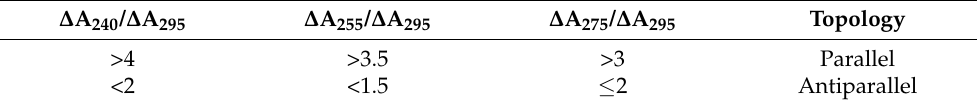
Table 2. Reference TDS factor values according to the type of topology